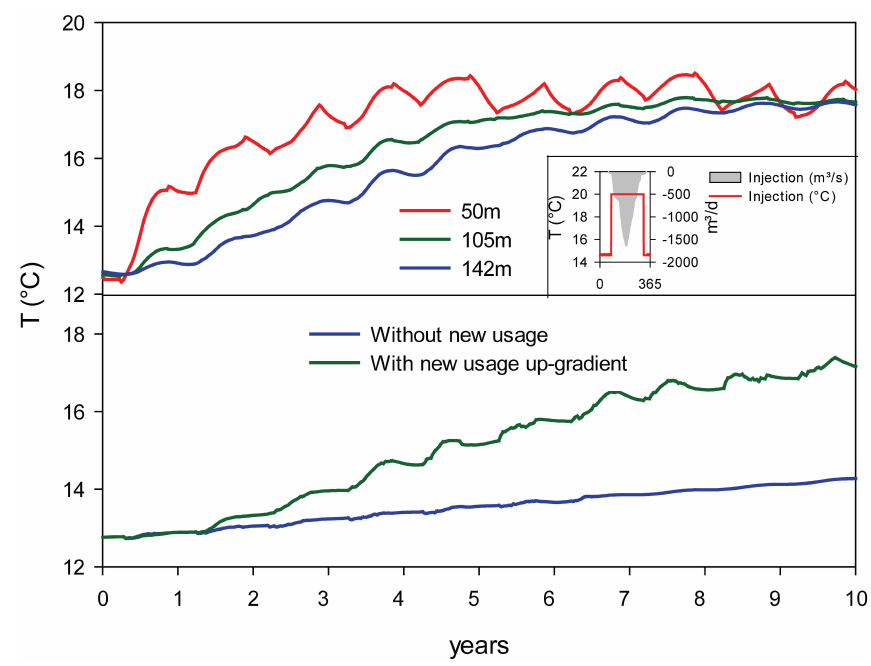
Fig. 9. Simulation of new thermal groundwater use up-gradient of the groundwater user B¨urgerspital who uses the extracted groundwater for cooling purposes (for locations see Fig. 1). Upper panel: thermal influence down-gradient of the new thermal groundwater user (imbedded subplot: simulated extraction and injection rates as well as temperatures of the injected water). Bottom panel: influence of the new thermal groundwater use on the thermal groundwater user